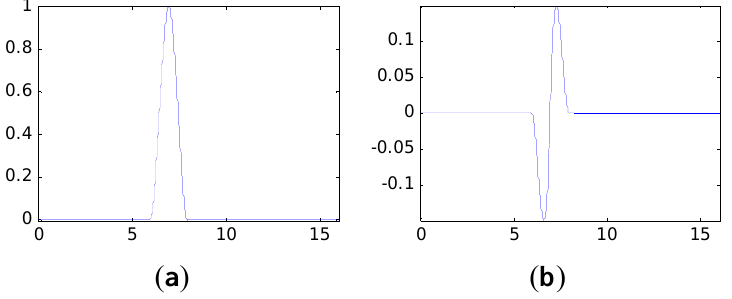
Figure 10. The multiple scaling functions of cubic Hermite splines. ( a )